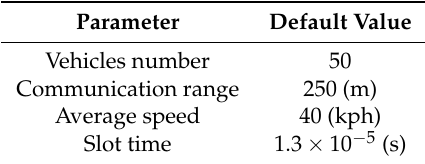
Table 3. Default parameter settings.